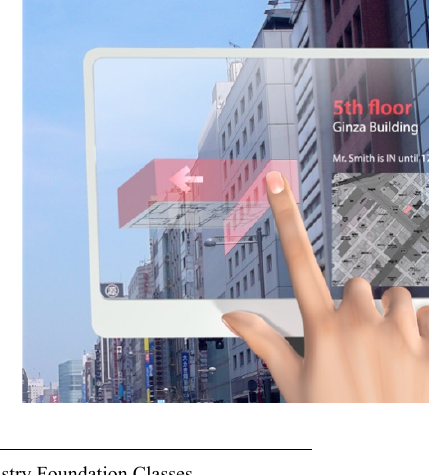
Figure 8. conceptual design for an augmented reality